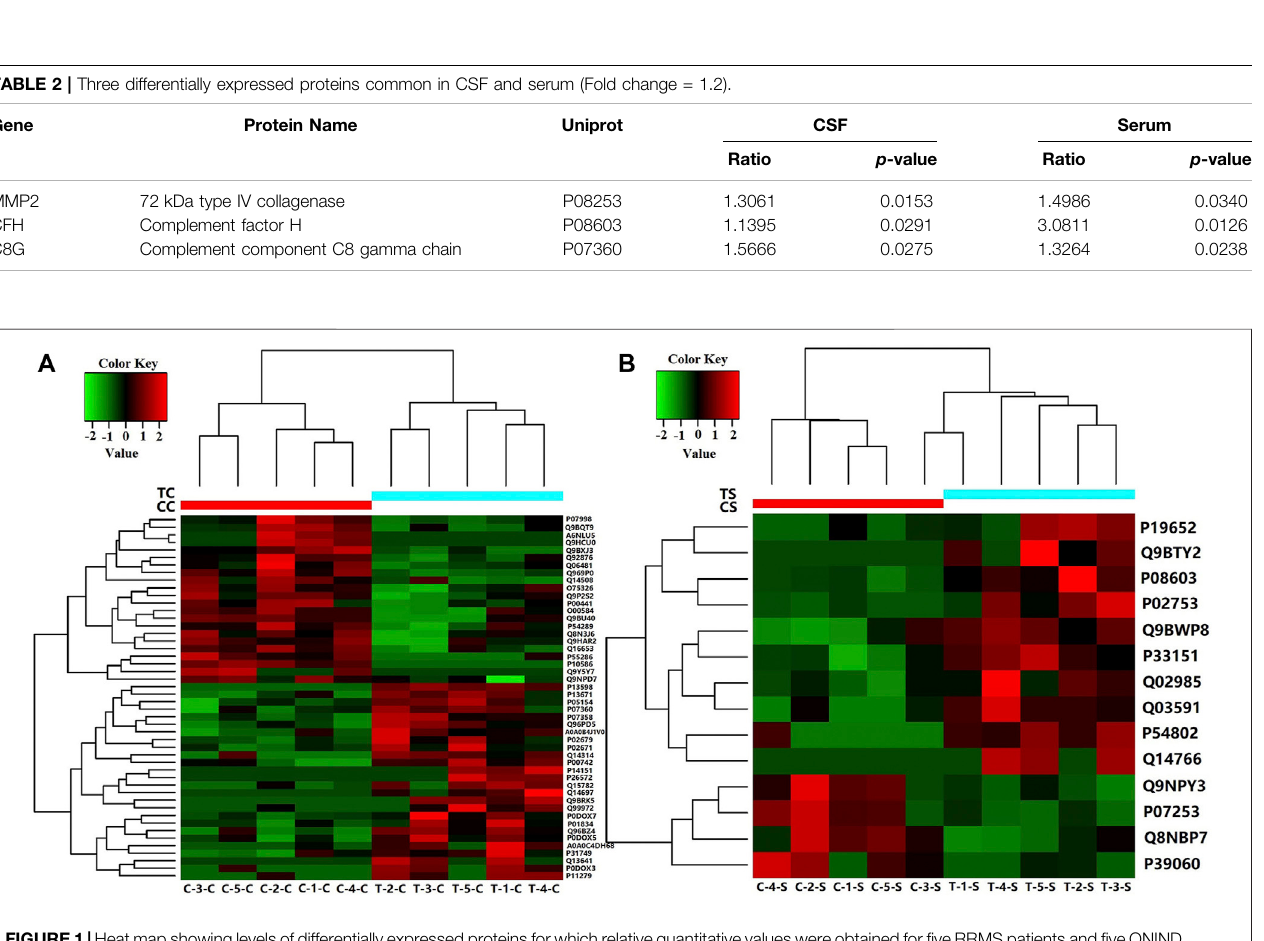
Frontiers in Genetics |